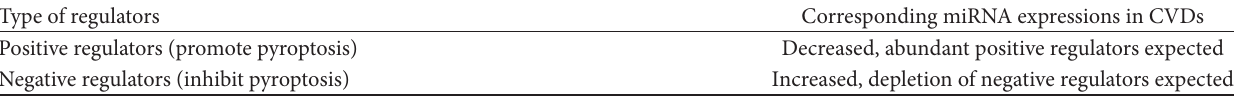
Table 2: Screening criteria of miRNAs, dependent on pyroptosis regulator type.